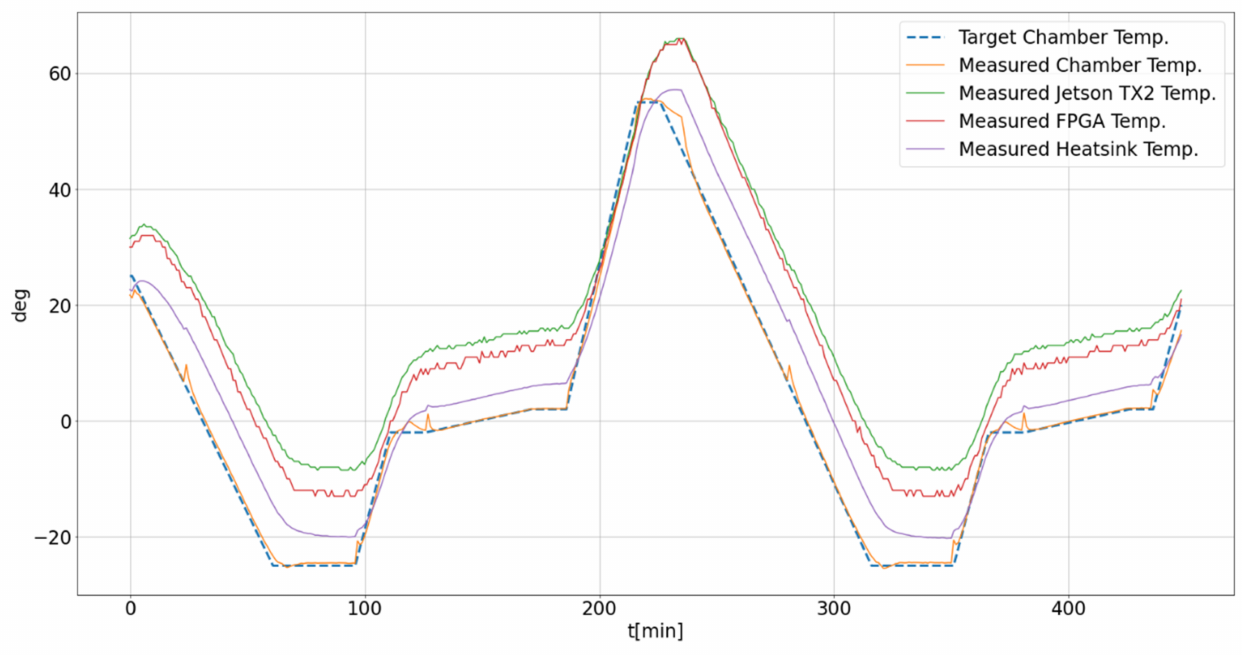
Figure 20. VVSP module temperature endurance